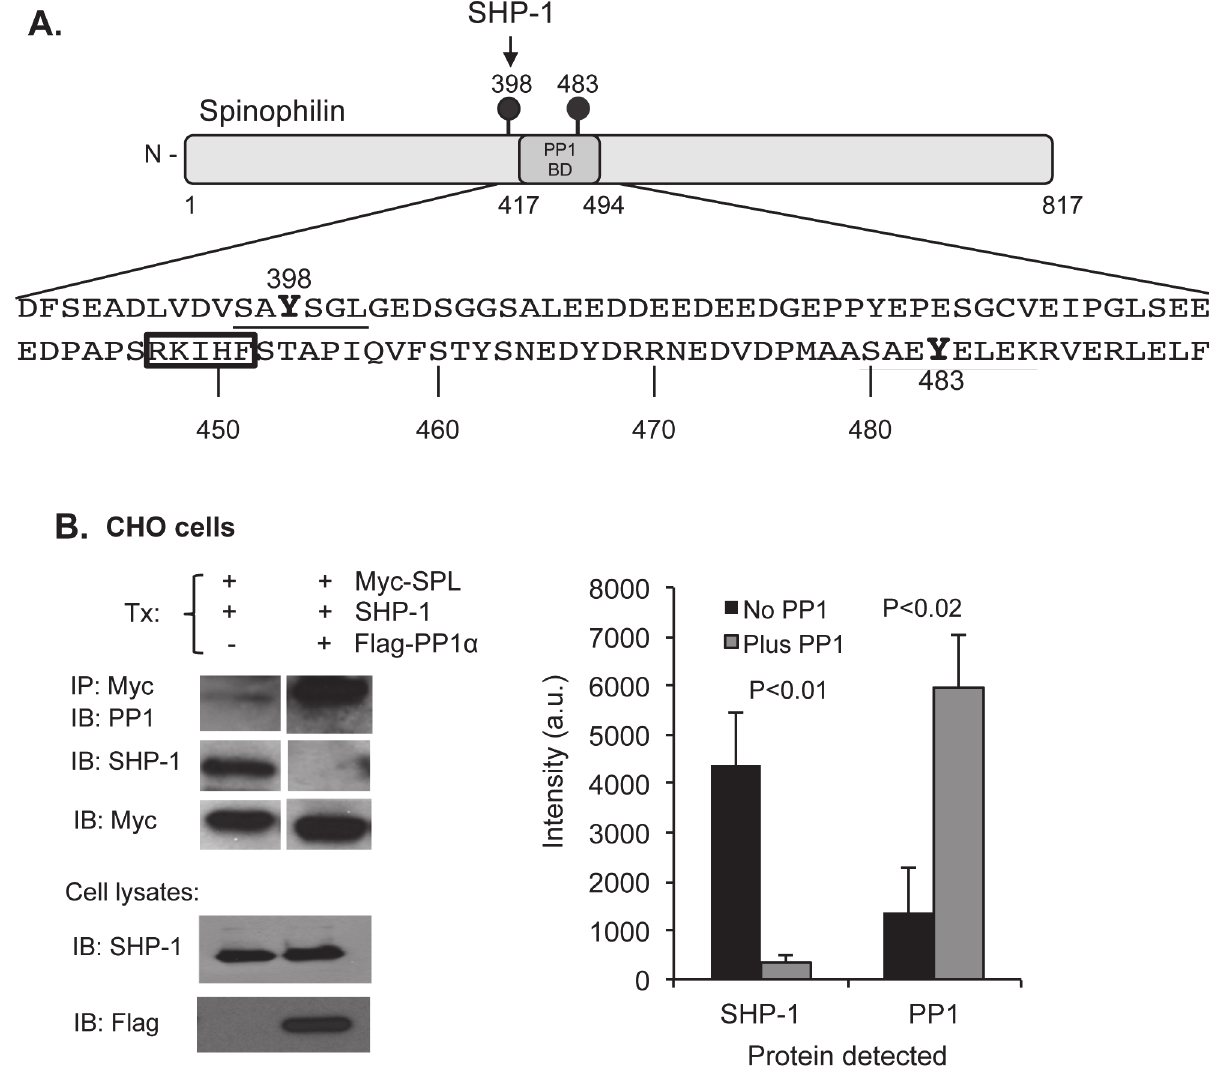
Fig 3. Competition of PP1 and SHP-1 for spinophilin. (A) A diagram of spinophilin showing the PP1 binding domain [31] and the SHP-1 binding site on phosphorylated Y398 [2]. There are two tyrosine phosphorylated residues in spinophilin: Y398 and Y483. The boxed RKIHF sequence matches a consensus sequence for PP1 binding (R/K)(R/K)(V/I)x(F/W) [27]. (B) Top : CHO cells were transfected with Myc-SPL, SHP-1 and Flag-PP1 α as indicated. Proteins were precipitated with anti-Myc and probed for either SHP-1 or PP1. Bottom : Western blots of transfected cell lysates probed for SHP-1 or Flag-PP1 α . The graph shows the amount of SHP-1 (left columns) or PP1 (right columns) that co-precipitated with SPL. For the black bars, only endogenous PP1 was present. For the gray bars, the cells were transfected with FLAG-PP1 (mean ± SEM, N =